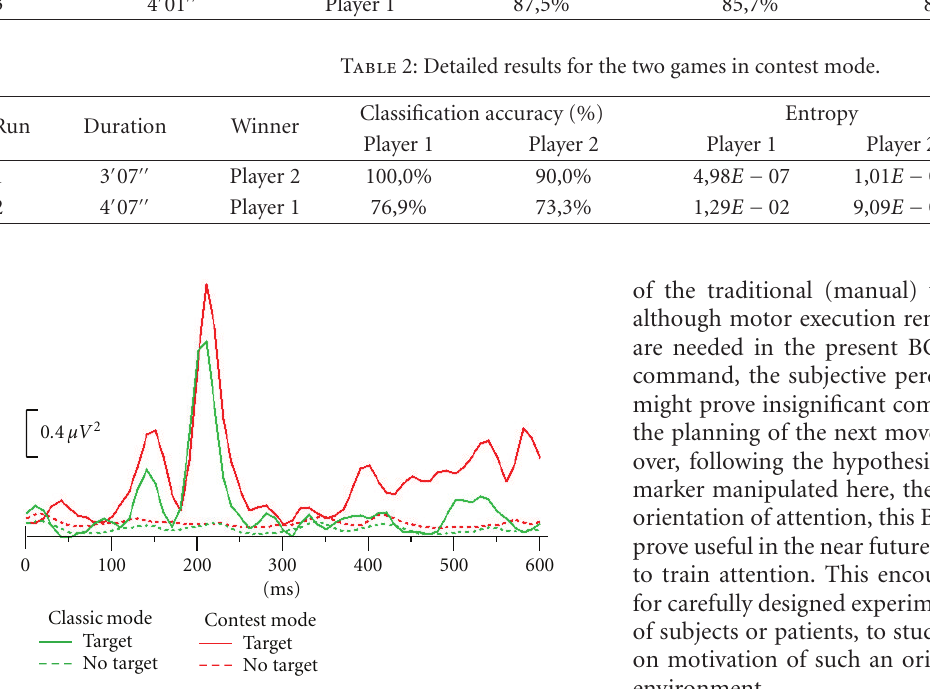
Figure 7: Global Field Power computed over five virtual channels for “target” and “nontarget” stimuli, in classic and contest modes (Player